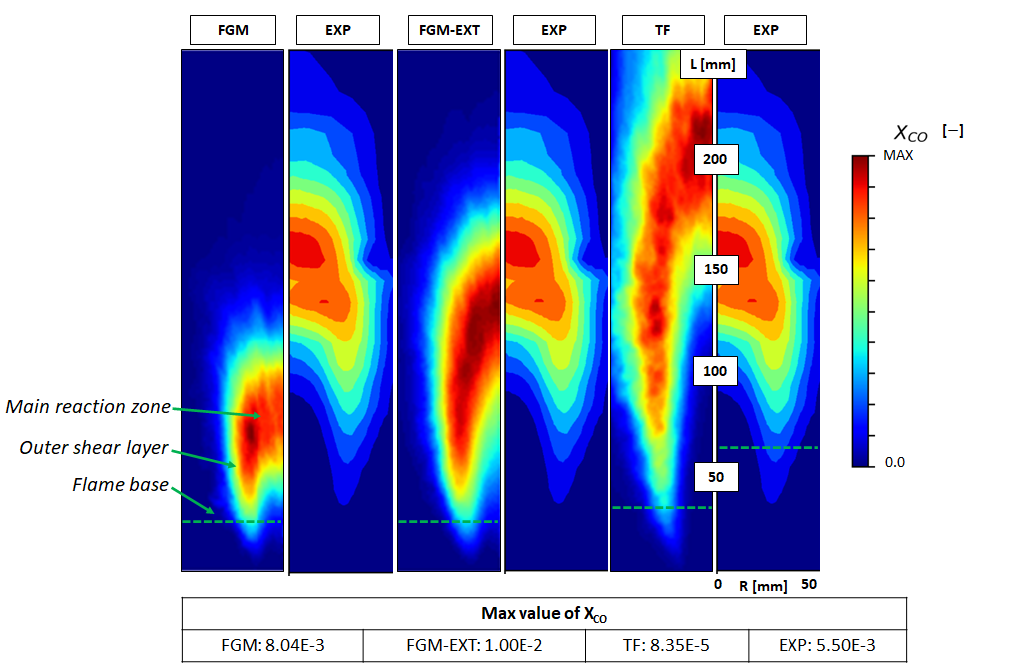
Figure 10. Contour maps of averaged CO mole fraction ( X CO ) for (from left to right ) FGM, FGM-EXT, TF combustion models, and experimental data from